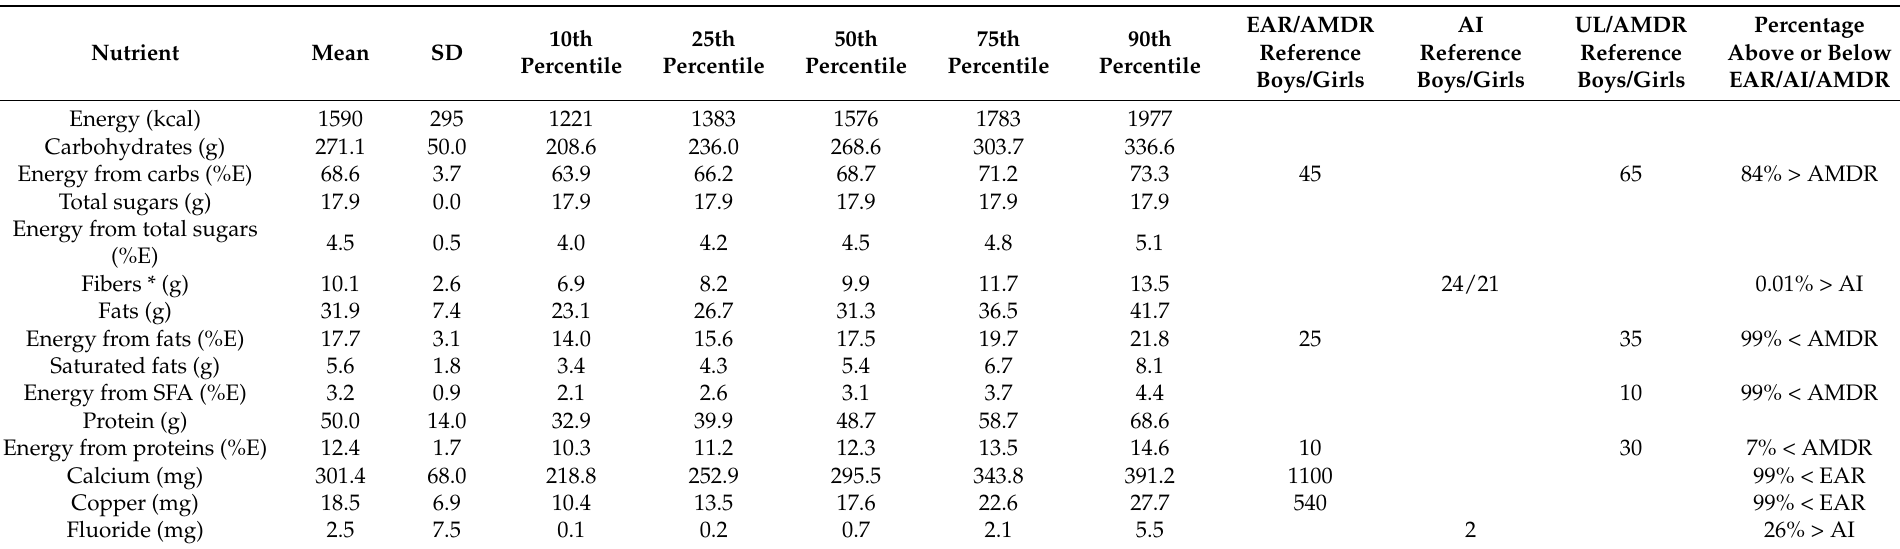
Table 3. Distribution of usual nutrient intakes and percentage of inadequacy in 9–13-year-old Nigerian